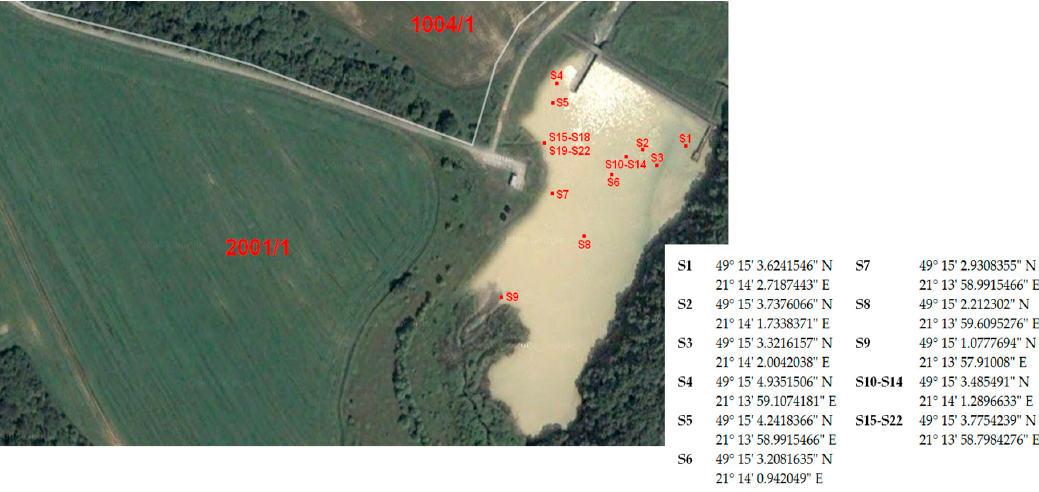
Figure 1. Particle size distribution measured for original and mechanically activated sediments.